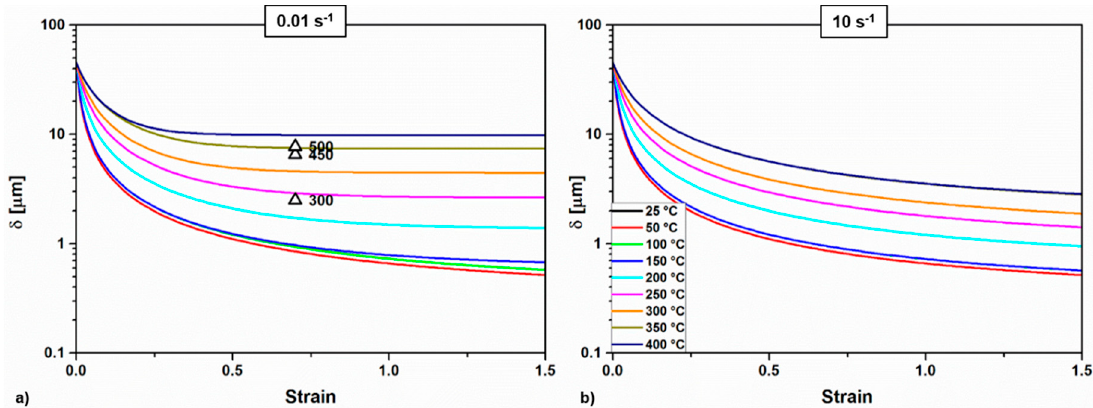
Figure 6. Evolution of the dislocation densities (modelled) as a function of temperature and for two selected strain rates. ( a , b ) interiors and walls dislocation densities, respectively, during deformation at 0.1 s − 1 , and ( c , d ) interiors and walls dislocation densities, respectively, during deformation at s − 1 . Materials 2018 , 11 , 1319 10 of 15